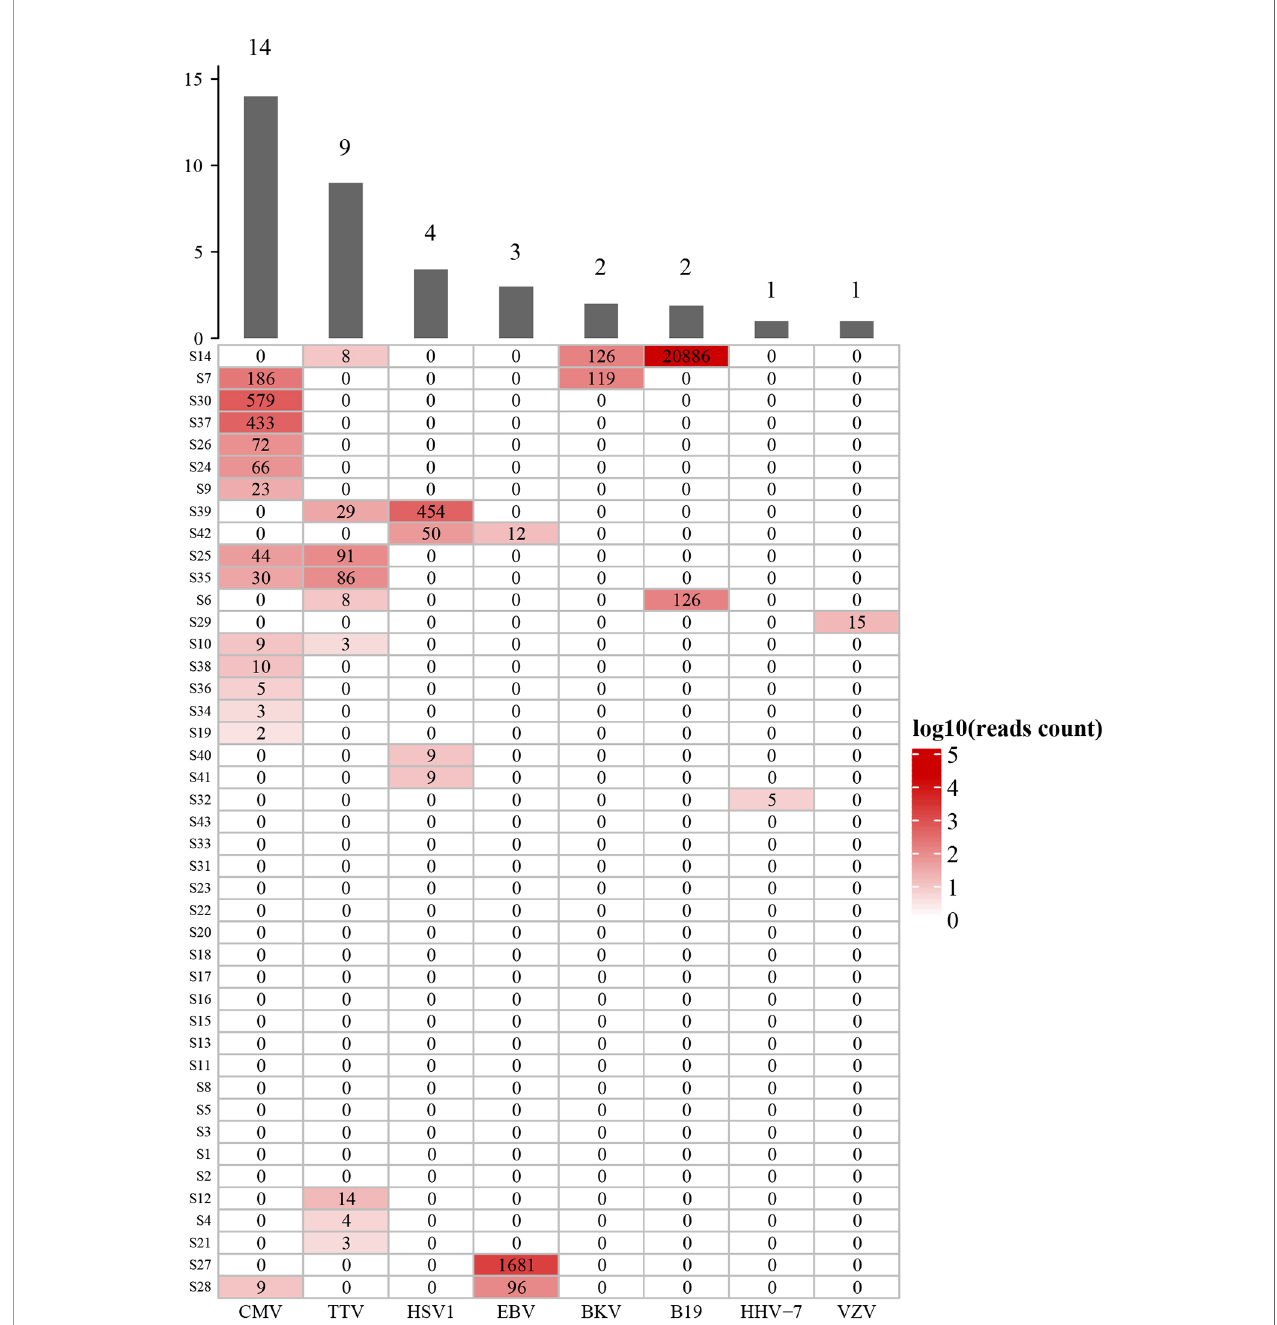
on the histogram represent the sample sizes of the corresponding virus. The numbers in the table represent the reads of mNGS results. S14 and S7 etc, sample number. The samples are sorted according to hierarchical clustering with Euclidean